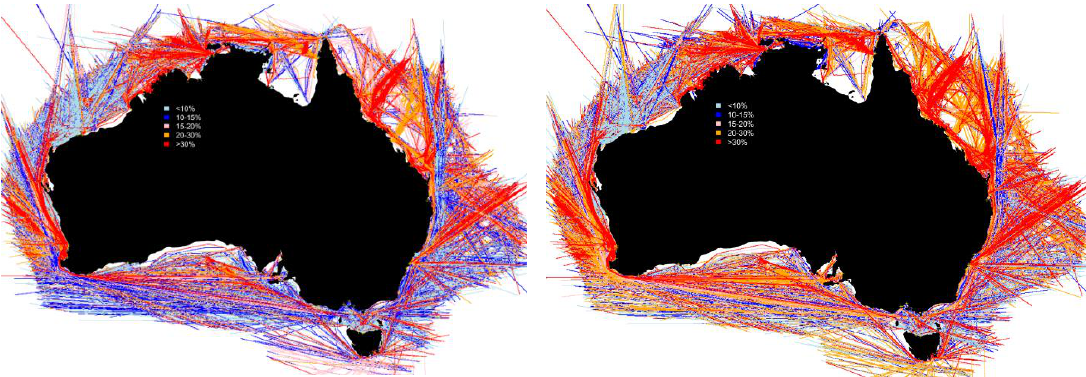
Figure 3. Change in risk exposure for powered groundings in 2020 ( left ) and 2025 ( right ) compared.